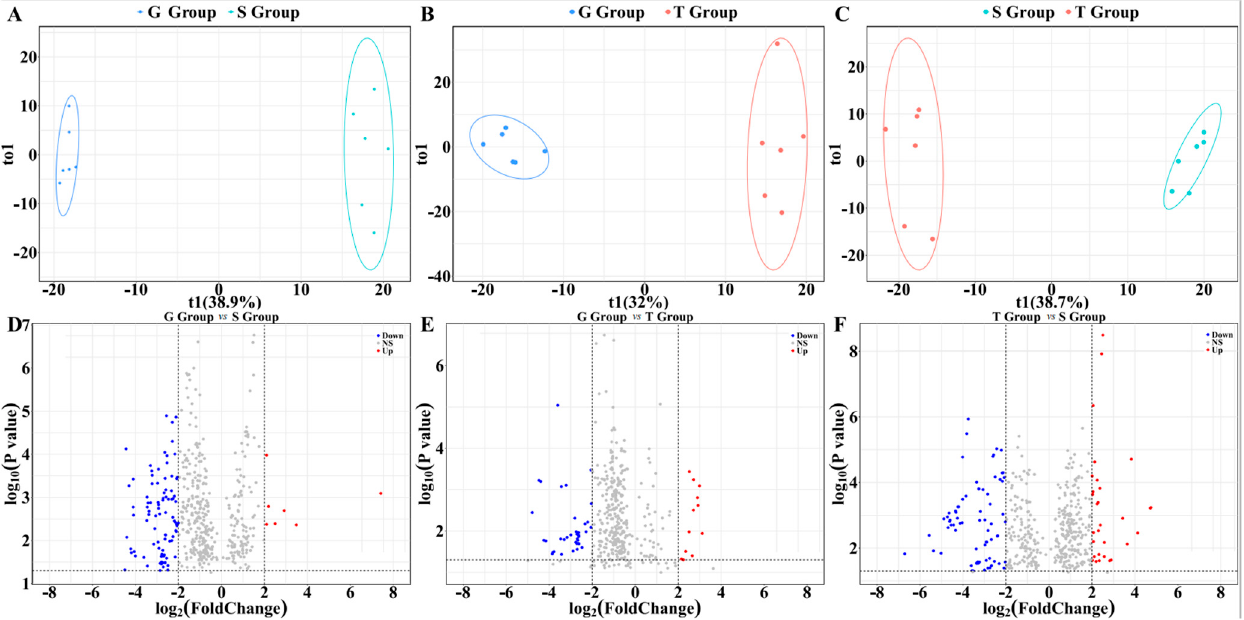
Figure 4. The effects of different cultivation methods on the metabolites ( n = 6). A supervised OPLS- DA model was used to compare the data. The G-Group meant that the sample was from greenhouse cultivation; S-Group meant that the sample was from stone epiphytic cultivation; T-Group meant that the sample was from live tree epiphytic cultivation. In ( A – C ), the x-axis represents the predicted principal component and the y-axis represents the orthogonal principal component. Each point rep- resents one sample. ( A ) compares the samples from greenhouse cultivation and stone epiphytic cul- tivation with parameters R 2 X: 0.483, R 2 Y: 0.997, and Q 2 : 0.93. ( B ) compares the samples from green- house cultivation and live tree epiphytic cultivation with parameters R 2 X: 0.527, R 2 Y: 0.986, and Q 2 : 0.916. ( C ) compares the samples from stone epiphytic cultivation and live tree epiphytic cultivation